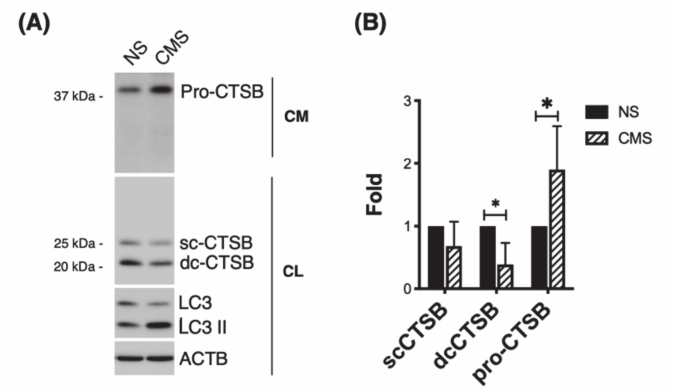
Figure 4. CTSB is secreted into the culture media in response to CMS. ( A ) Protein levels of CTSB in whole-cell lysates (5 µ g) and culture media (15 µ L) from hTM cells subjected to CMS (8% elongation, 24 h), compared to non-stretched controls. ( B ) Relative quantification of pro-CTSB, sc-CTSB, and dc- CTSB calculated from the densitometric analysis of the bands and compared to non-stretched controls. Data are shown as the mean ± S.D. * p < 0.05; two-tailed paired Student’s t -test, n = 4 and 5 for cell lysate and culture medium, respectively. NS: non-stretched; CMS: cyclic mechanical stretch; CM: culture media; CL: cell lysate. LC3 serves as control for mechanical